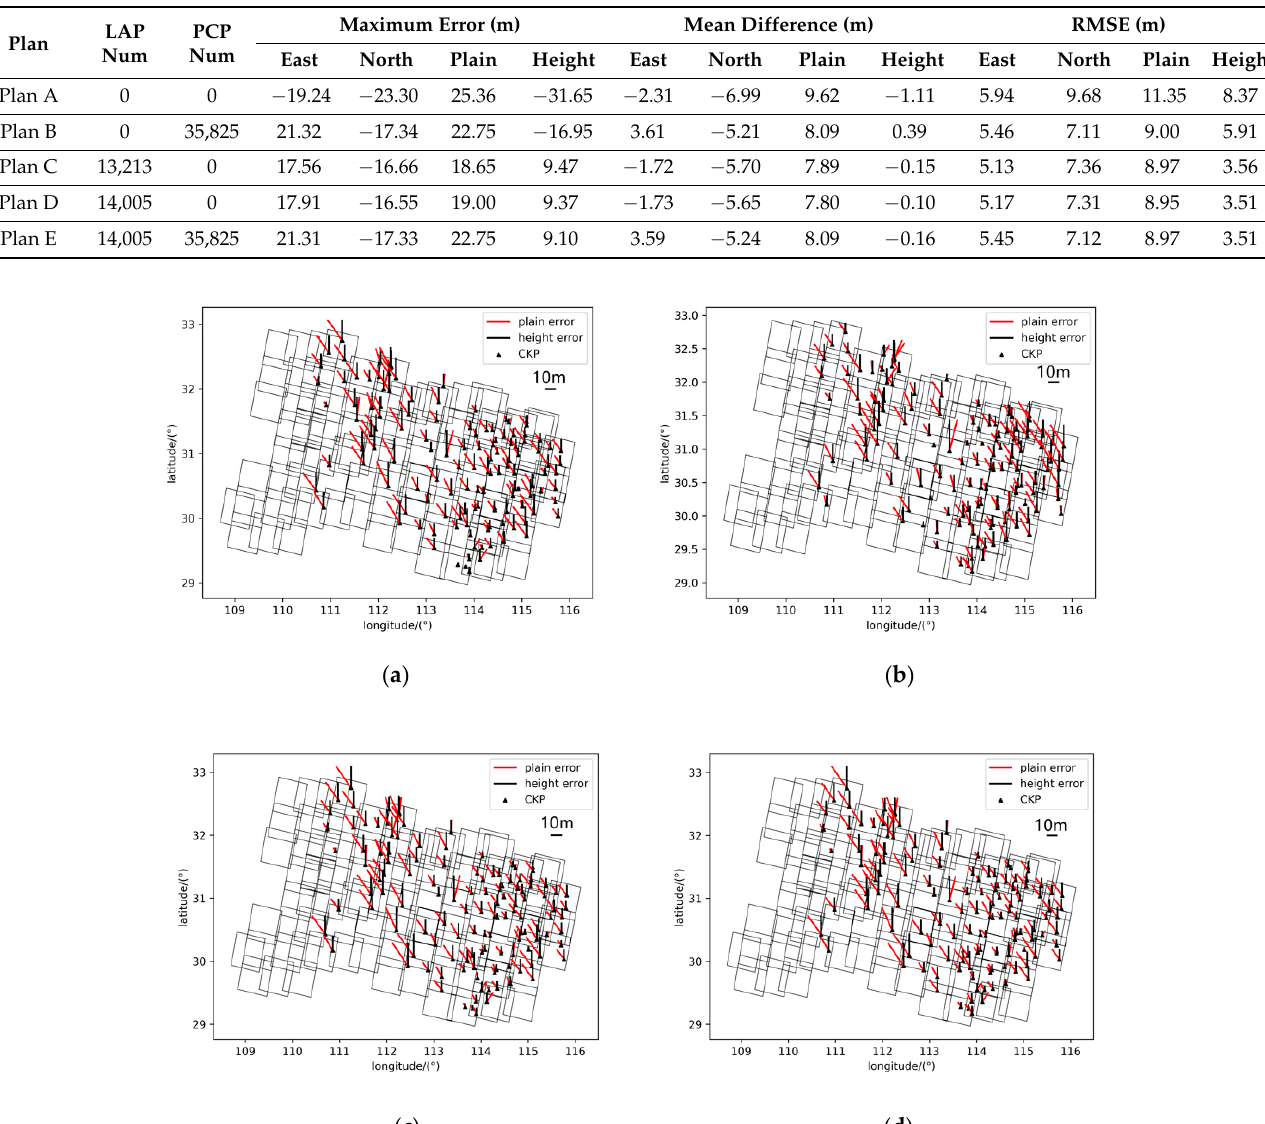
Table 3. Total Adjustment Results of Mapping Satellite-1 Stereo Images.